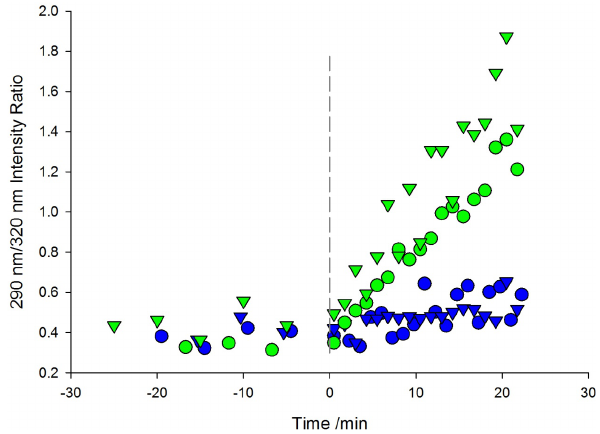
Fig. 4. The harmine 290/320 intensity ratio measured at the frozen salt water surface (green symbols) and at the frozen artificial seawa- ter (blue symbols) surface as a function of time. The dashed line in- dicates the time ( t = 0) at which a 50 sccm flow of N 2 passing over a 12.75wt% NH 4 OH(aq) solution held at 253 K was introduced to the chamber. The pre-freezing pH of the salt water samples was adjusted with NaOH(aq) to a pH ∼ 8.1, to be the same as the equi- librium pre-freezing pH of the seawater samples. The final melted pH of the salt water samples was > 10 while the final melted pH of the seawater samples was < 10. The different shapes of the symbols represent two separate